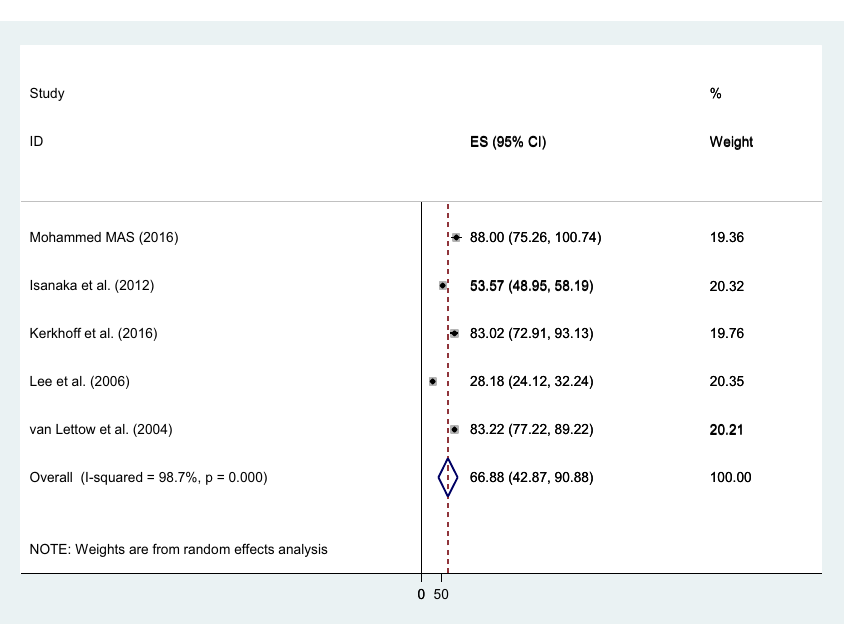
Figure 4. The pooled prevalence of anemia among male TB